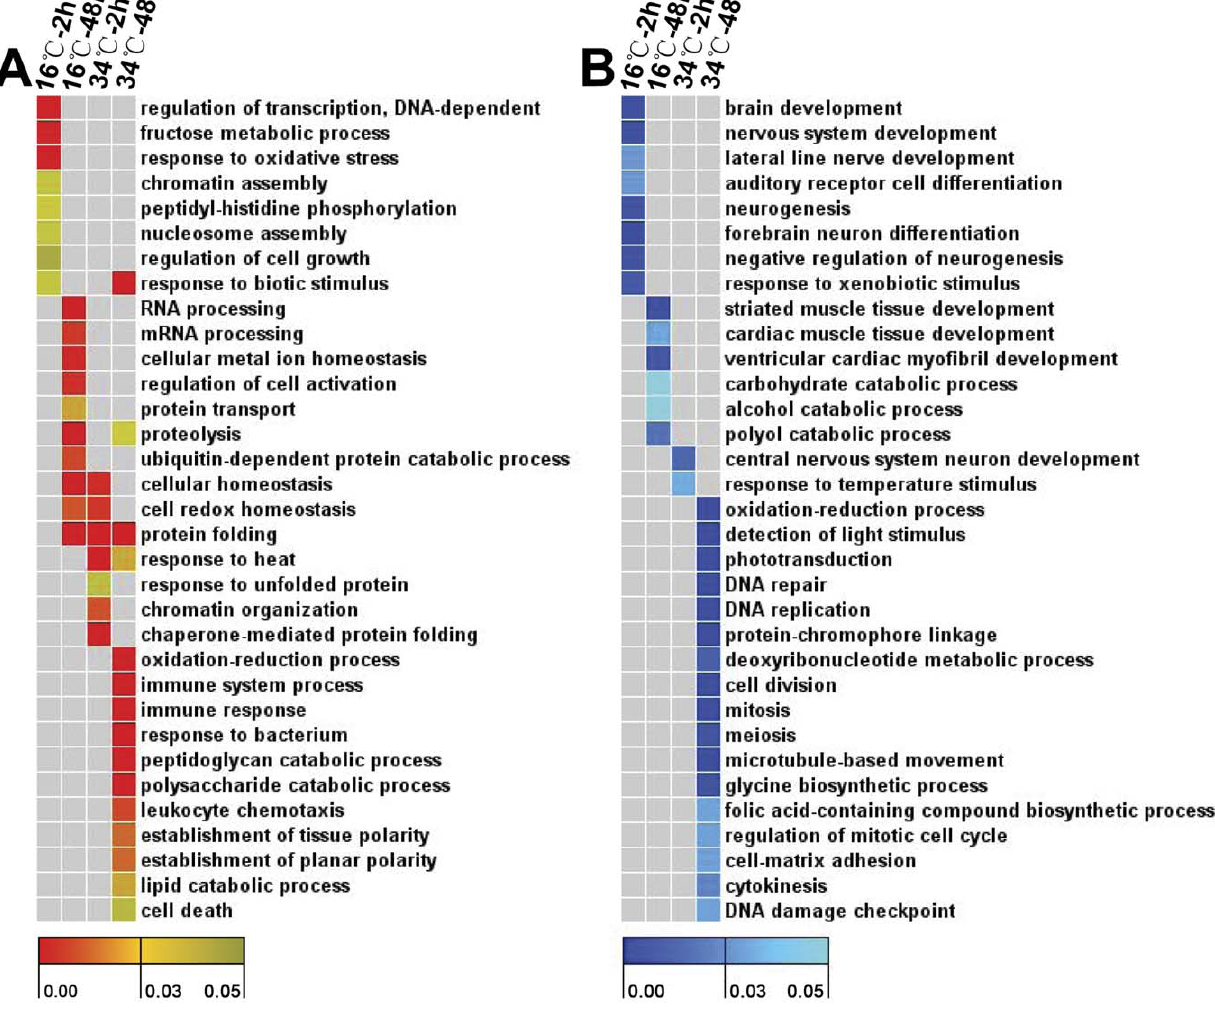
Figure 6. Heat maps of GO enrichment analysis for temperature-regulated genes. ( A ) Up-regulated genes. ( B ) Down-regulated genes. Genes up or down-regulated at each time point were submitted to GO enrichment analysis using GOEAST web-based software (http://omicslab. genetics.ac.cn/GOEAST/index.php). The results of GO enrichment analysis are displayed in Table S7. GO terms were selected to display in heat maps according to their statistical significance and locations in the GO tree. Columns and rows in the heat maps indicate treatments and enriched biological process GO terms, respectively. Sample names were displayed above the heat maps. Color scales indicate p values of enrichment tests and gray cells represent an empty value or a value . 0.05.